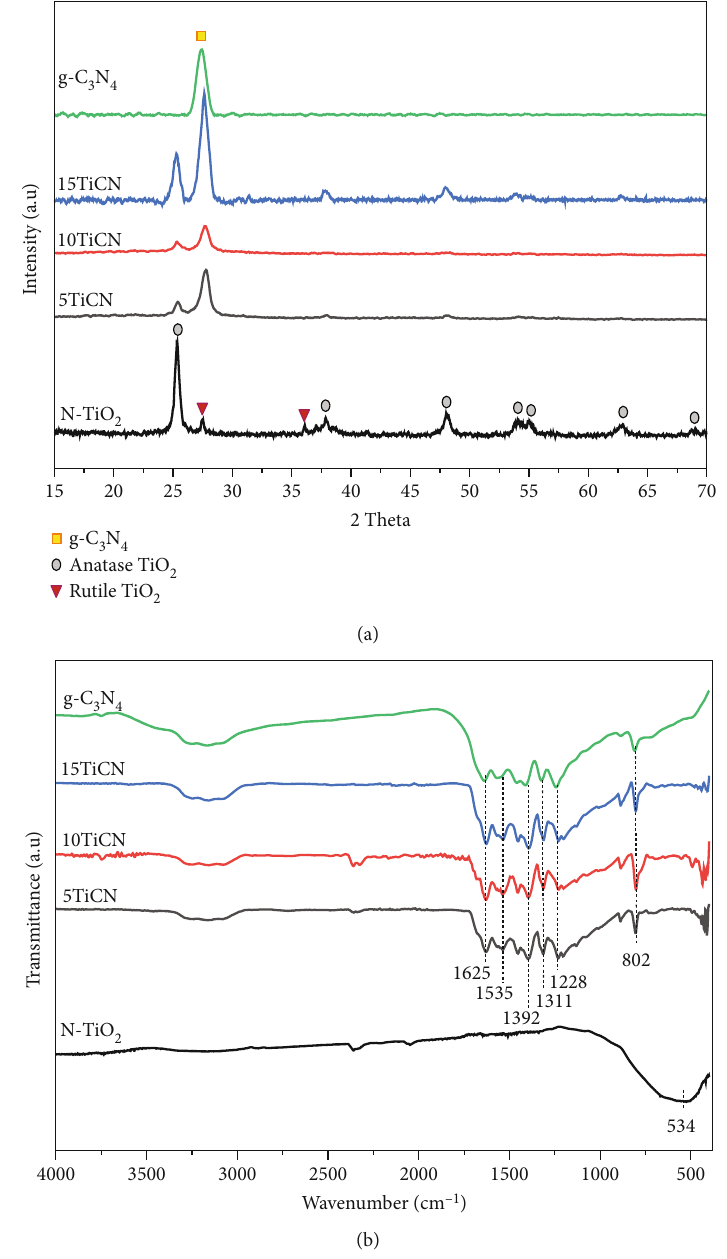
Figure 2: XRD patterns (a) and FTIR spectra (b) of g-C